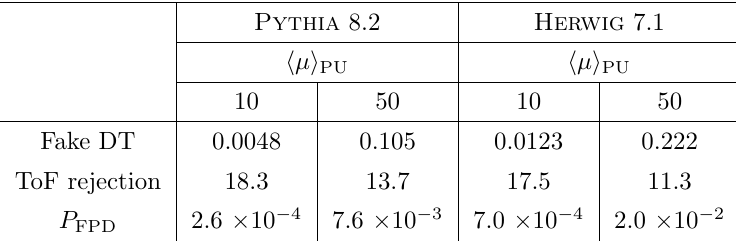
Table 6 . Probabilities of fake double-tagged events, rejection factors due to ToF detectors and overall probabilities to observe in one bunch crossing two forward protons in the FPDs and an inelastic vertex in the central detector consistent with that obtained by ToF detectors within the time resolution of 10